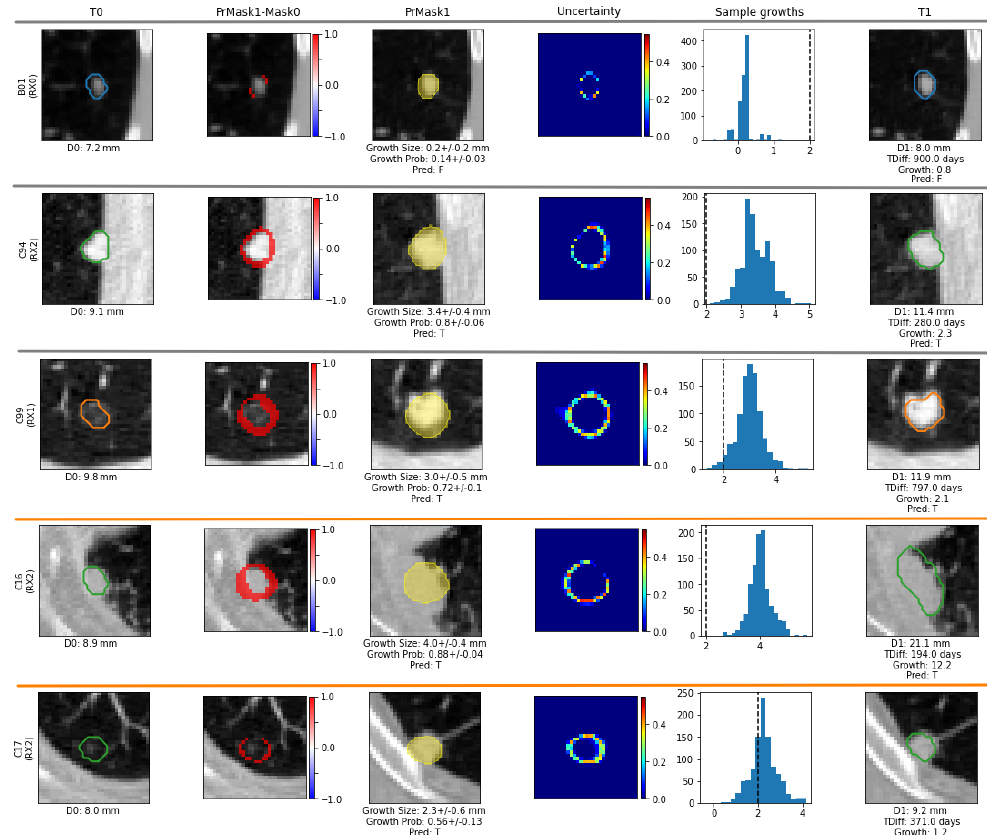
Figure 6. Visualization results of five different test cases. The first column is the initial nodule at T 0 overlapped with the segmentation of a radiologist. The second shows, overlapped with the nodule at T 0 , the difference between the ground truth segmentation at T 0 and the predicted mean segmentation at T 1 . The third provides, overlapped with the nodule at T 1 , the predicted tumour mean segmentation. The fourth is the estimated uncertainty probability map with the per-pixel standard deviation. The fifth shows the histogram of the (K = 1000) estimated tumour diameter growths (dashed line is the 2 mm tumour growth threshold). The last shows the nodule at T 1 overlapped with the segmentation of the radiologist at T 1 .